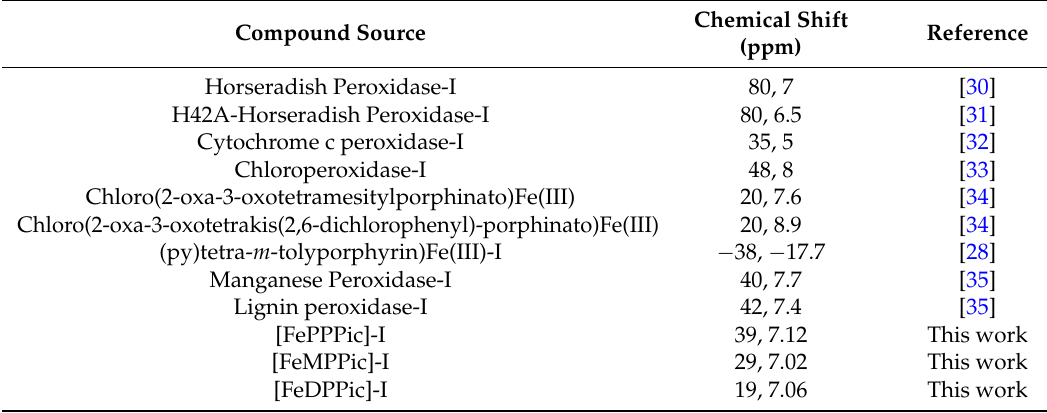
Table 2. Selected ESR spectra data of compound I and compound II of peroxidases and their model compounds, contrasting the chemical shifts for [pinch porphyrinsFe IV =O] + ¨ presented